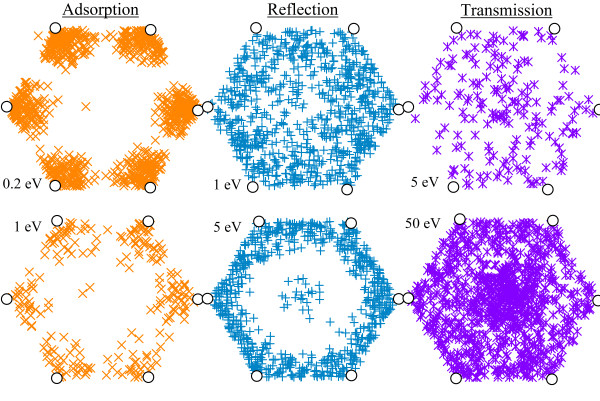
Positions of reflection, transmission, and adsorption events for the quantum-classical calculations. In a representative graphene hexagon, using SCC-DFTB. Adsorption (left) shows clustering of hydrogen atoms around the lattice carbons. Reflection (center) is most probable at the perimeter of the hexagon where interactions are strongest. Transmission (right) can occur at most points in the lattice for high energies but tends to occur at the hexagon center due to the low barrier.